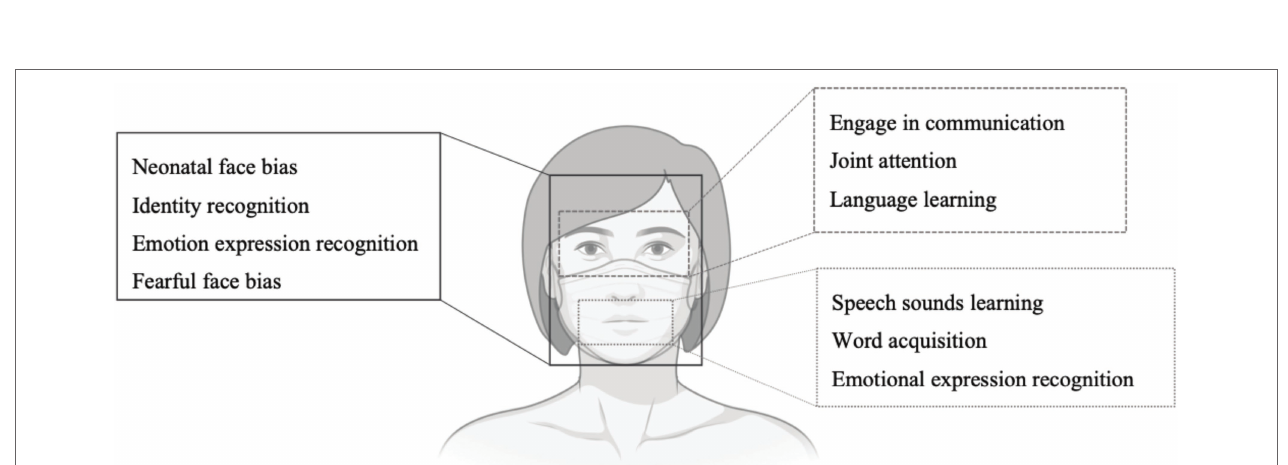
FIGURE 2 | Age periods studied in the literature for each of the addressed topics.